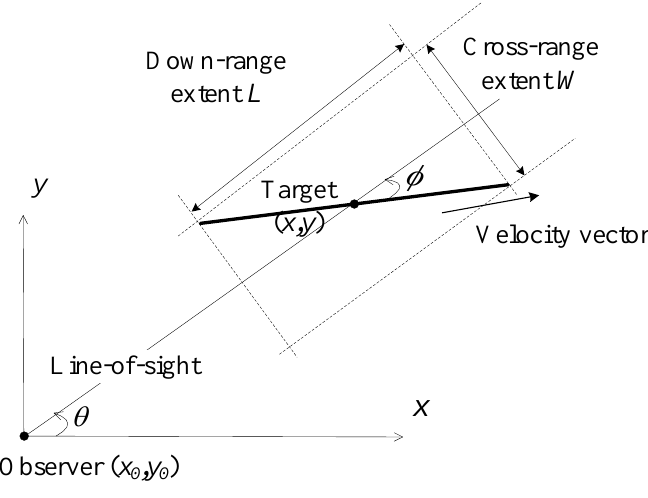
Figure 1. The stick shaped extended target